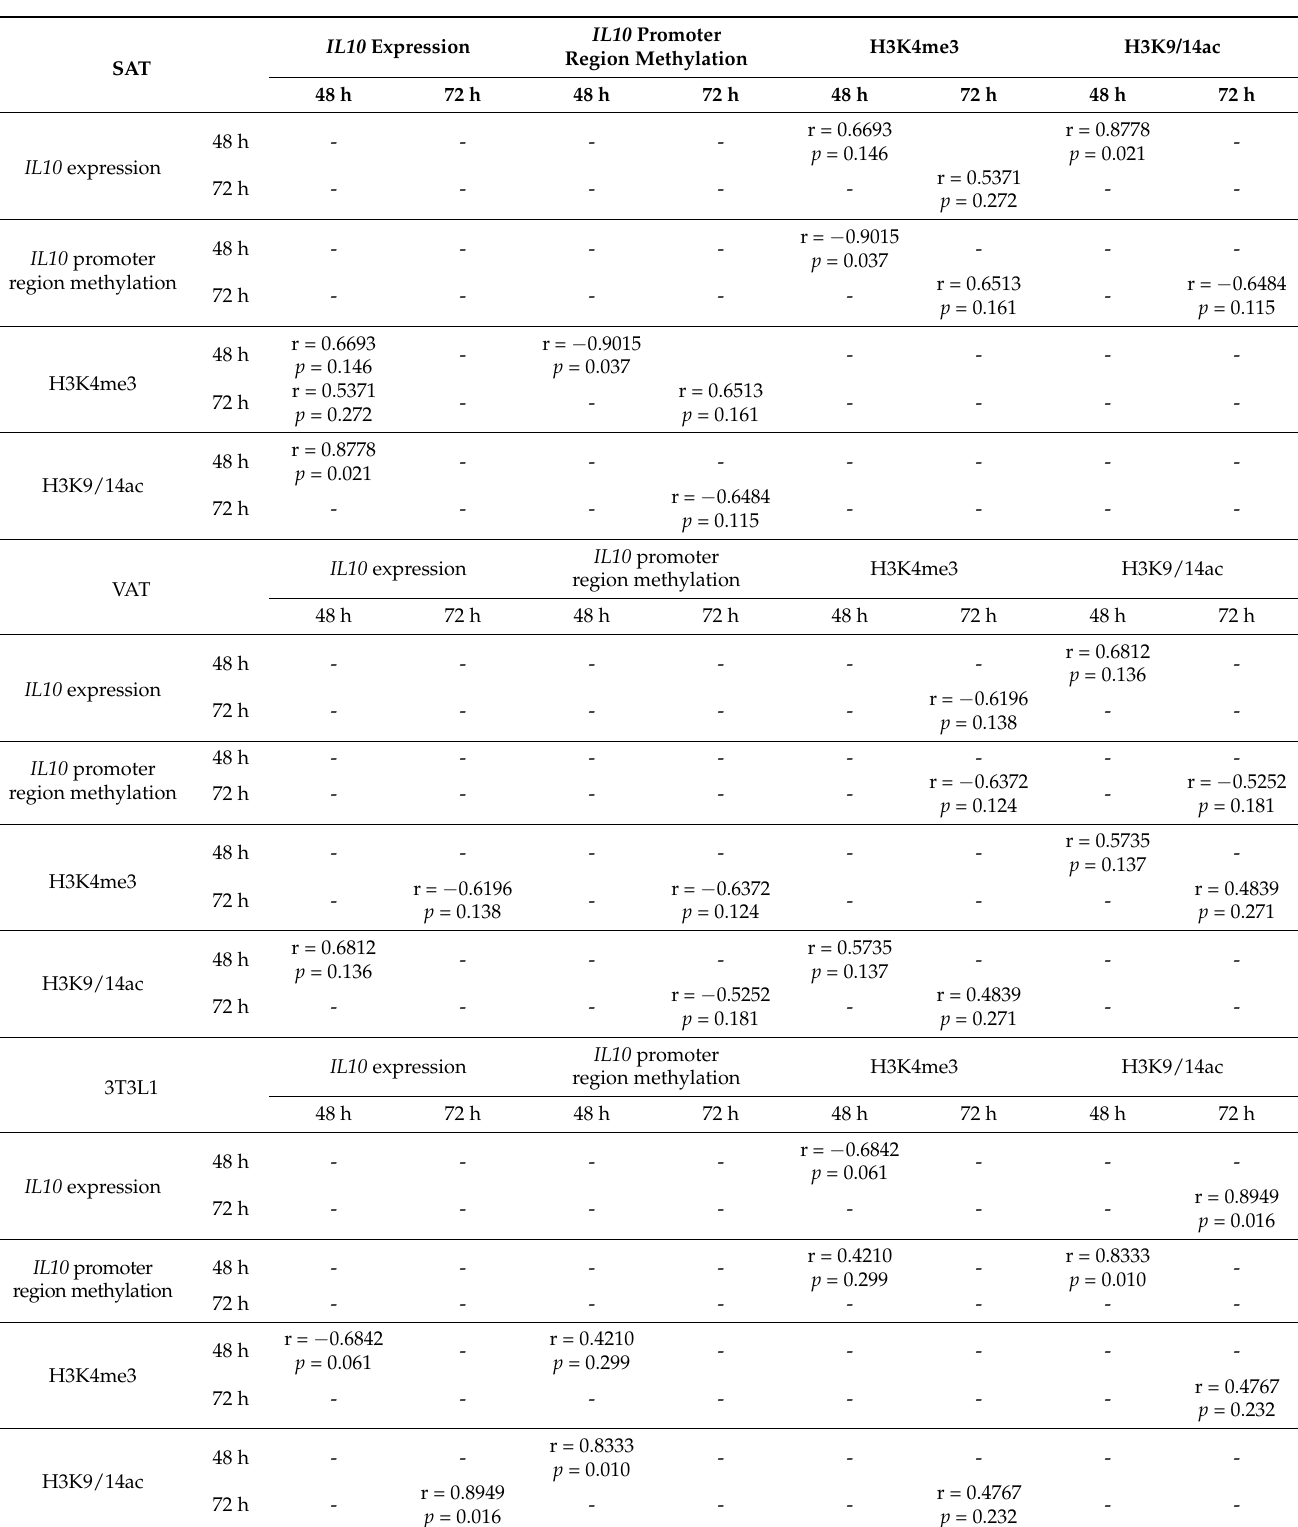
Table 2. Results of correlation